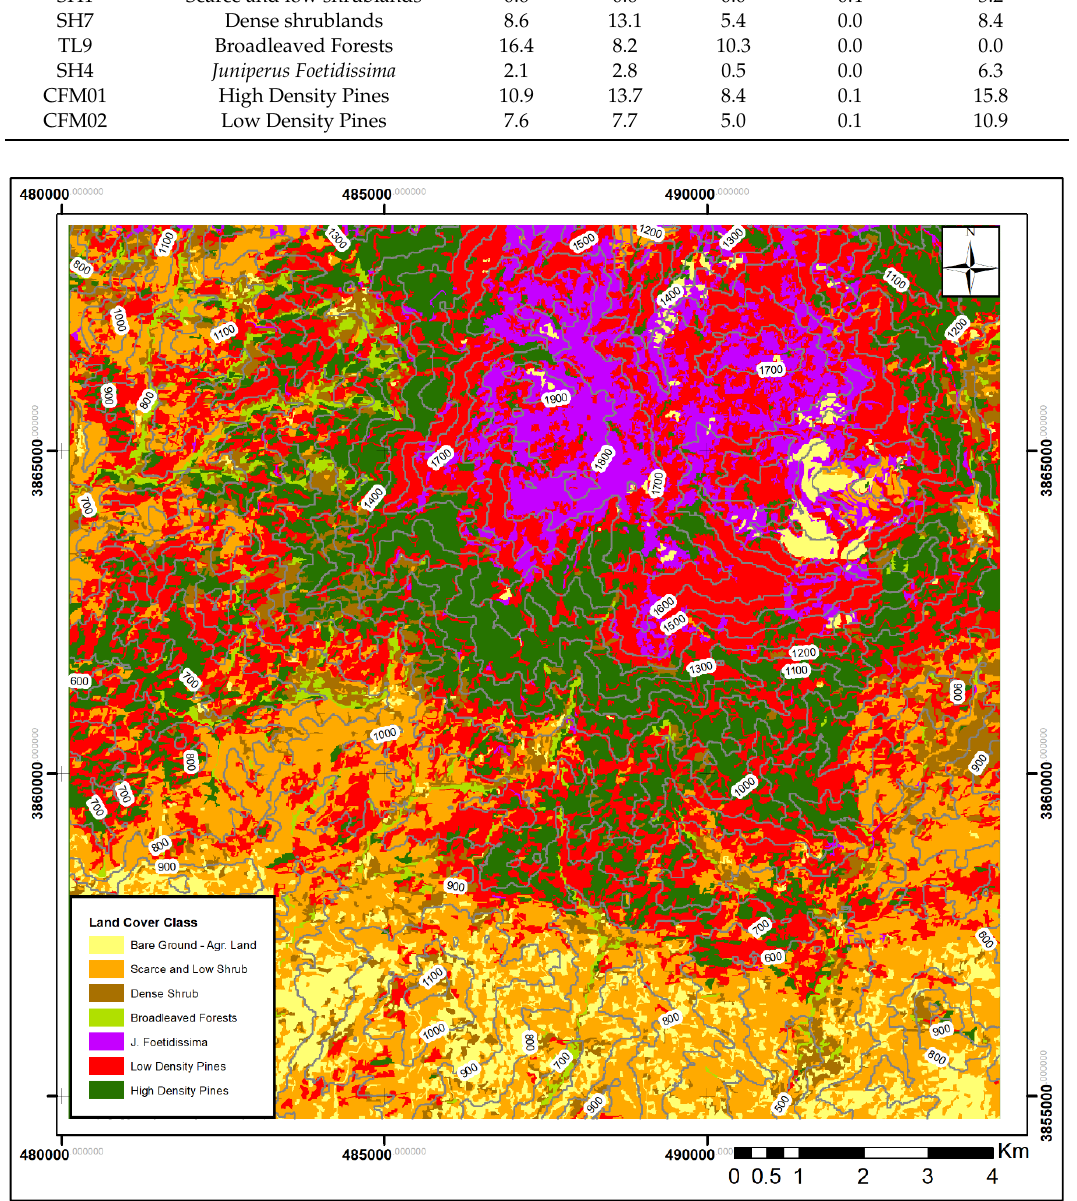
Figure 2. Distribution of land cover types in the study area according to the OBIA classification.